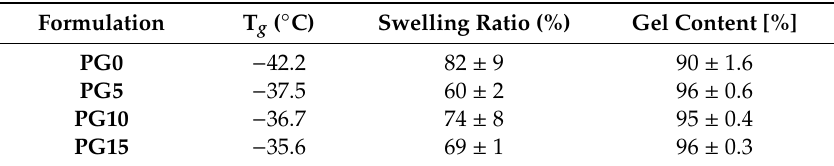
Table 2. Hydrogel Table 2. Hydrogel properties.